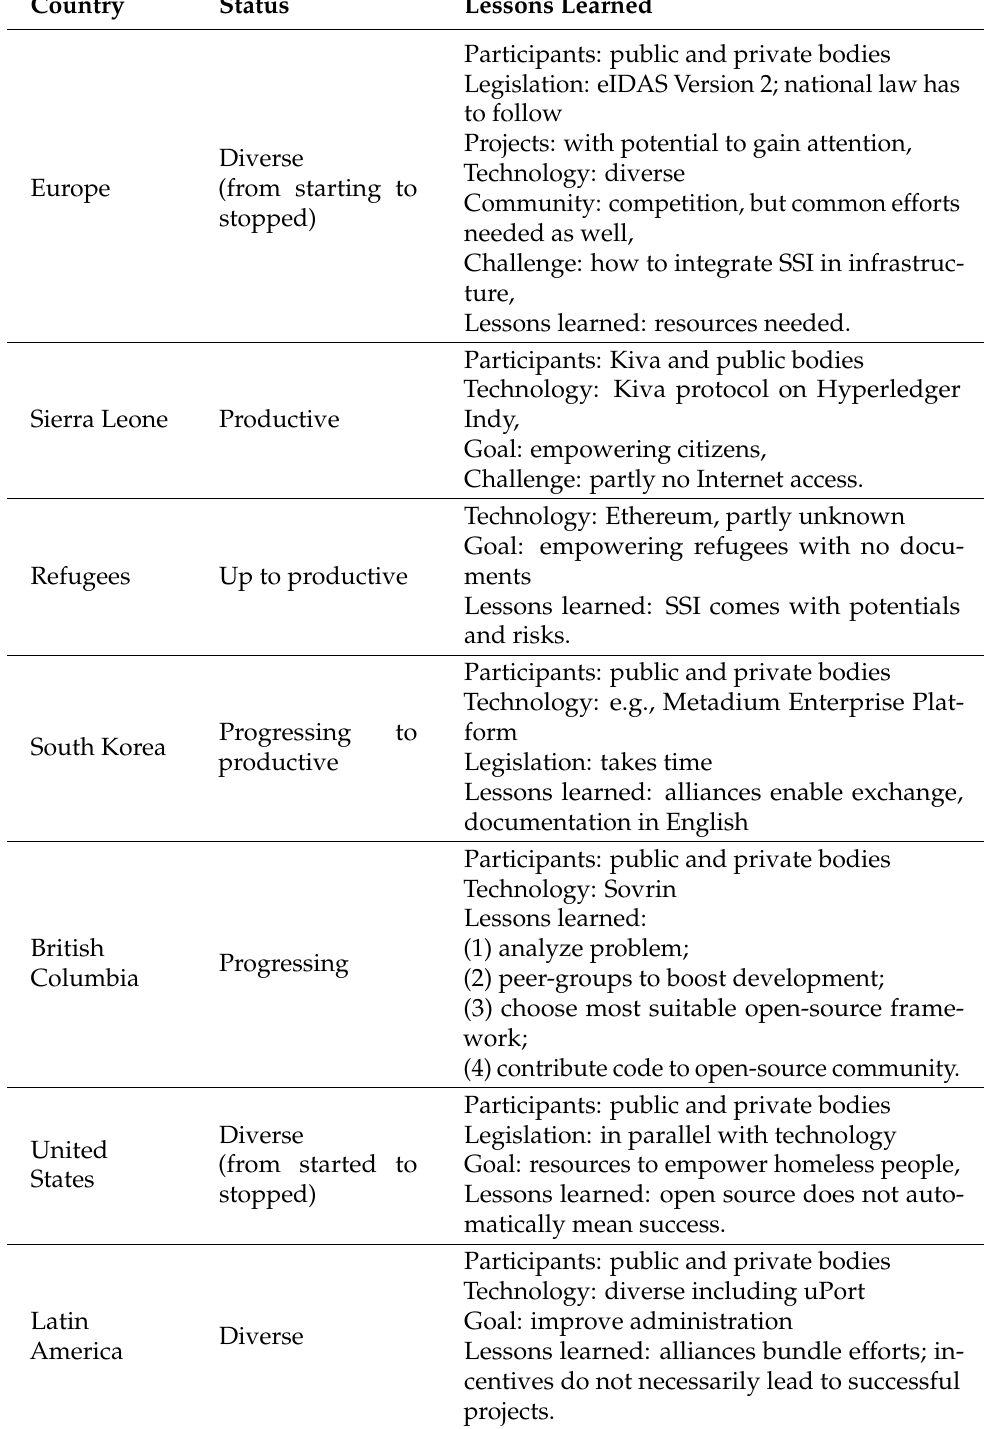
Table 2. Summary of SSI